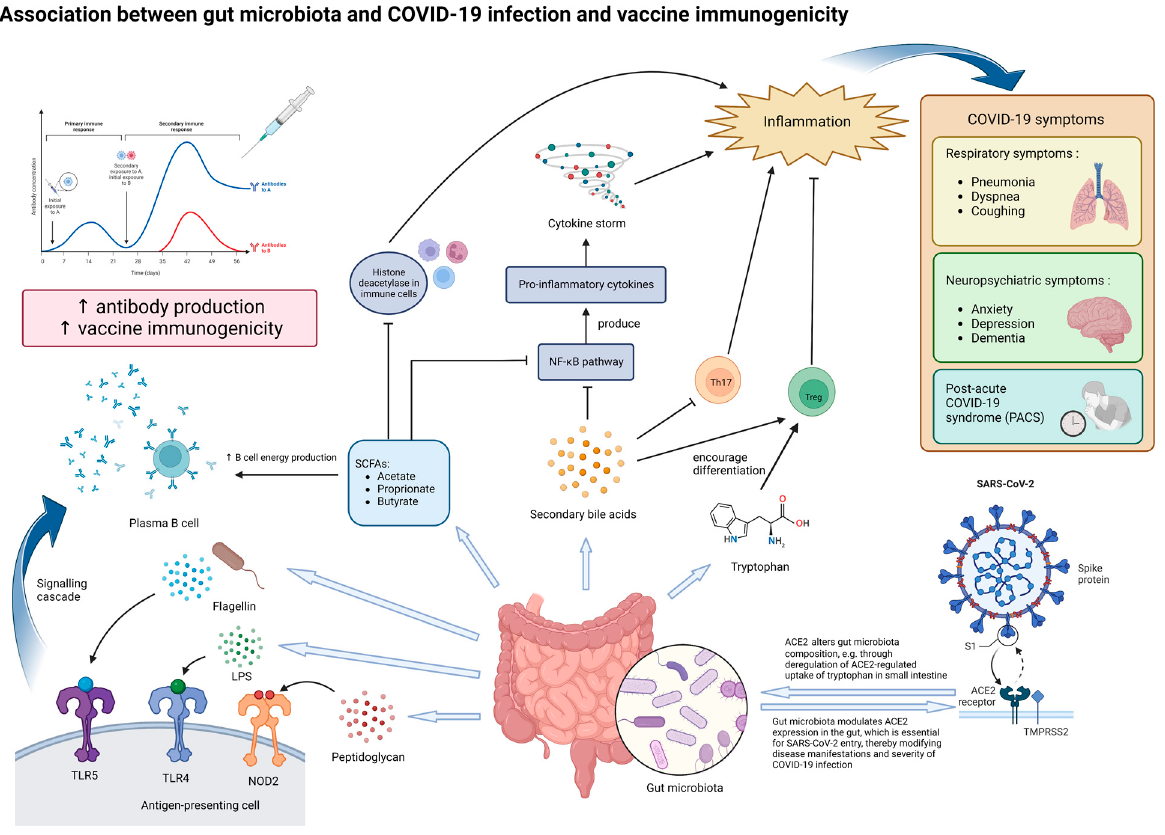
Figure 1. Potential mechanisms underlying the effect of gut microbiota on SARS-CoV-2 infection and vaccine immunogenicity. The gut microbiota and its metabolites, particularly those with immunomodulatory properties, can influence both the manifestations of COVID-19 and vaccine immunogenicity. In the context of COVID-19, dysbiosis of the gut microbiota may increase the severity of inflammation and various symptoms through modulating ACE2 expression in enterocytes and altered secretion of immunomodulatory molecules, such as tryptophan, SCFAs and secondary bile acids. Dysbiosis may potentially contribute to the production of cytokine storms, which produce more severe symptoms. In the long run, dysbiosis may be associated with persistent COVID-19 symptoms and inflammation, termed as post-acute COVID-19 syndrome (PACS). In the context of vaccine immunogenicity, lipopolysaccharides (LPSs), flagellin, peptidoglycan, and SCFAs secreted by the gut microbiota can enhance antibody production to vaccination by plasma B cells, thereby improving vaccine immuno- genicity. Abbreviations: ACE2, angiotensin-converting enzyme 2; LPS, lipopolysaccharide; NOD2, nucleotide-binding oligomerization domain-containing protein 2; TLR-4, Toll-like receptor 4; TLR-5, Toll-like receptor 5; SCFA, short-chain fatty acid; NF- κ B, nuclear factor- κ B; Th17, T helper 17 cells; Treg, regulatory T